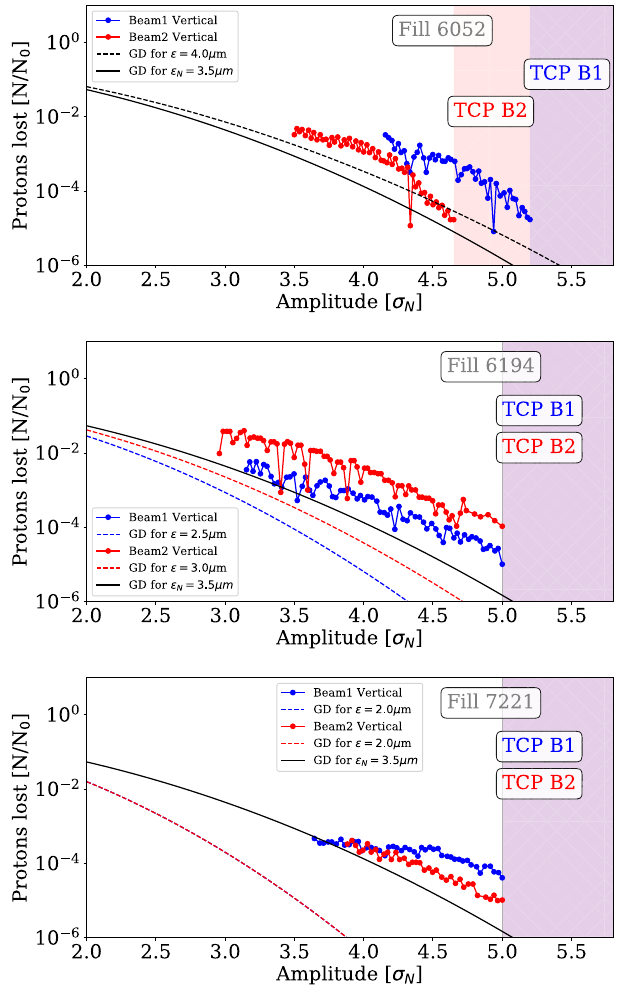
FIG. 9. Reconstructed beam profiles from the beam losses as a function of the jaw position during the selected scraping test (details in Table III), expressed in nominal beam size. All cases refer to the vertical plane, plotted along with Gaussian distribu- tions (GDs) for different emittances. Fill 6052 (top), fill 6194 (middle), and fill 7221 (bottom). The TCP collimator jaw position at the end of the alignment, when the scan starts, is indicated by the color area on the right.